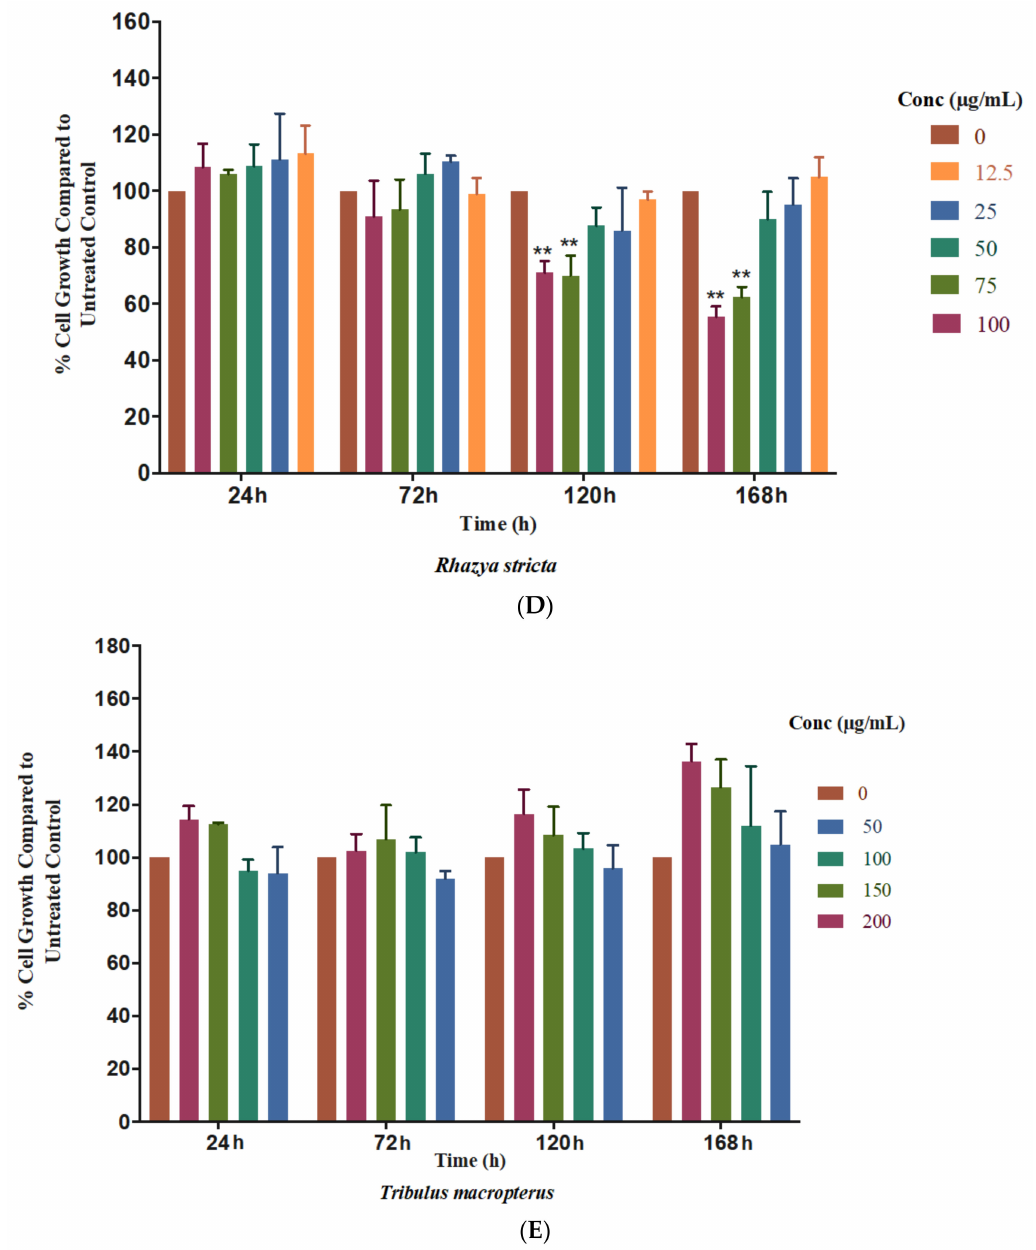
Figure 1. Percentage of HaCaT cell viability and proliferation with ( A ) Aizoon canariense extract (50, 100, 150, and 200 µ g/mL in the culture medium) ( B ) Citrullus colocynthis extract (10, 15, 20, 25, 50, and 100 µ g/mL in the culture medium) ( C ) Maerua crassifolia extract (50, 100, 150, and 200 µ g/mL in the culture medium) ( D ) Rhazya stricta extract (12.5, 25, 50, 75, and 100 µ g/mL in the culture medium) ( E ) Tribulus macropterus extract (50, 100, 150, and 200 µ g/mL in the culture medium) at 24, 72, 120, and 168 h compared to the untreated control (mean ± S.D.). The results were obtained through three independent experiments. Statistical analysis of significant changes of the treated cells versus the untreated controls (* p < 0.05, ** p < 0.01, and *** p <